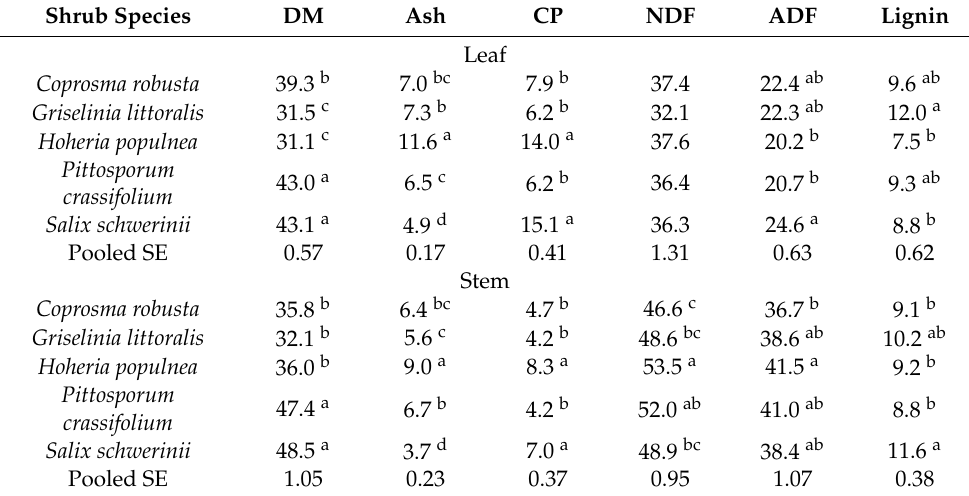
Nutrient values with different superscripts in columns for leaf and stem are different at p <